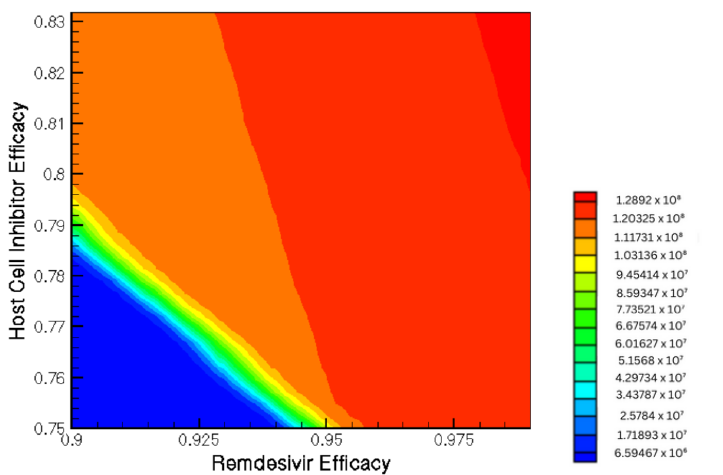
Figure 7. Contour plot shows the viral load as a function of Remdesivir and host-cell entry inhibition combination therapy.